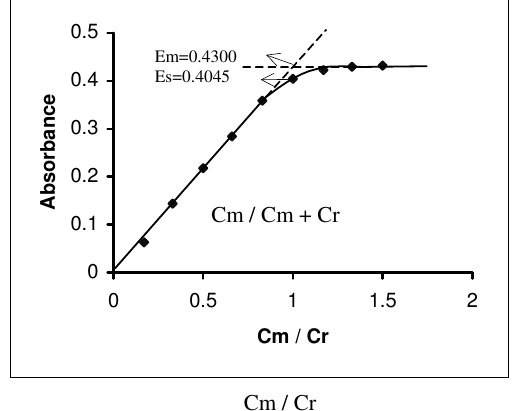
Figure 3. Mole-Ratio method for V(V)-HnPBAO Compex Plot of Yoe and Jones method for determination of M:L ratio 0.001 M V(V), 0.001 M HnPBAO, pH = 5.0, λ = 450